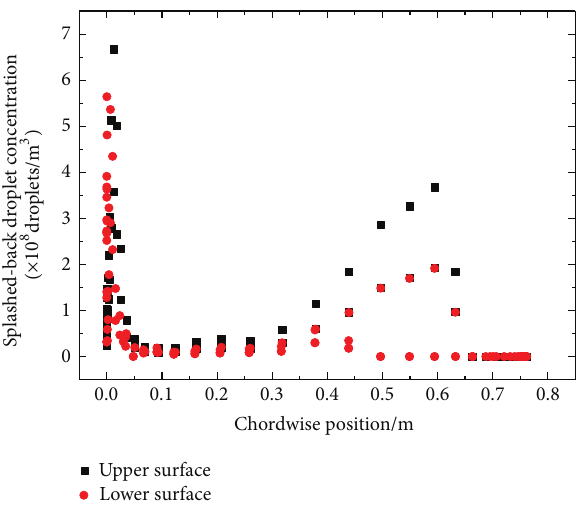
Figure 19: Droplet concentration within the second cell layer from the airfoil surface at AOA = 8